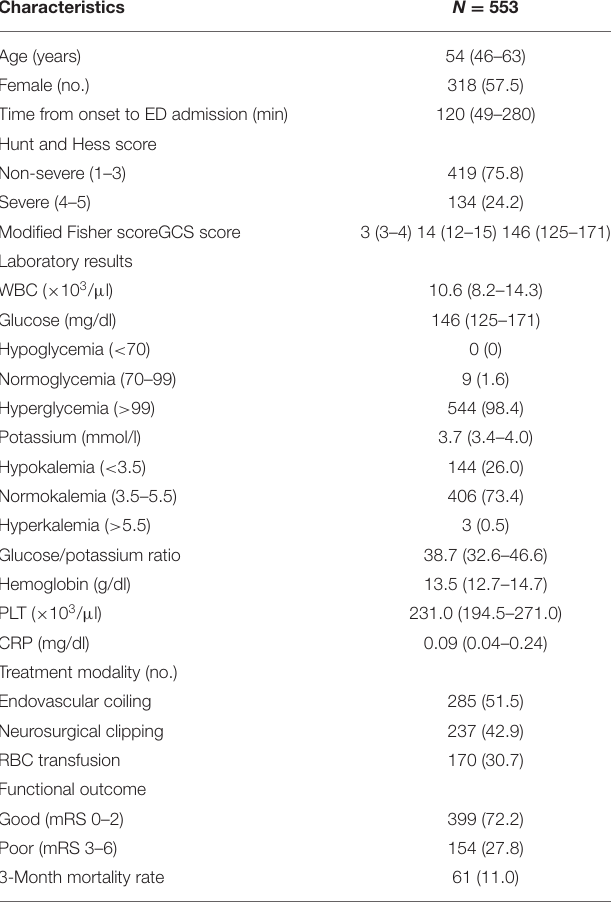
TABLE 1 | Characteristics and outcomes of the study population. Characteristics